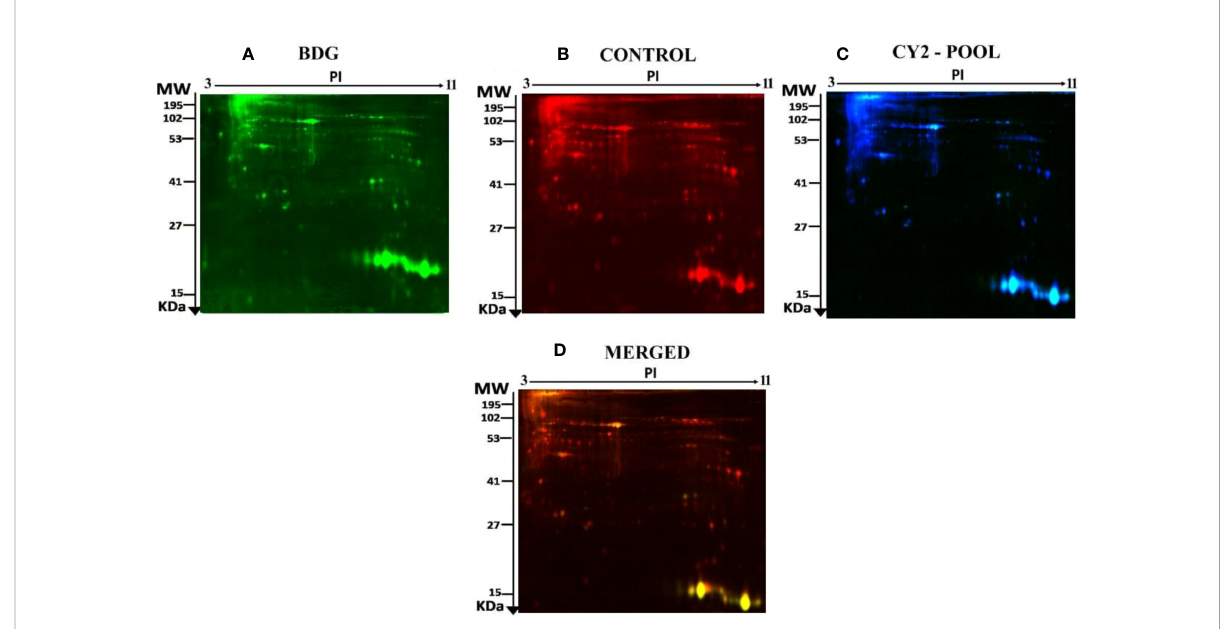
FIGURE 1 Representative fl uorescent protein pro fi le of a 2D-DIGE comprising tissue samples from BDG patients labelled with Cy3 (A) , Cy5 (B) , pooled internal control labelled with Cy2 (C) , and merged image (D) .